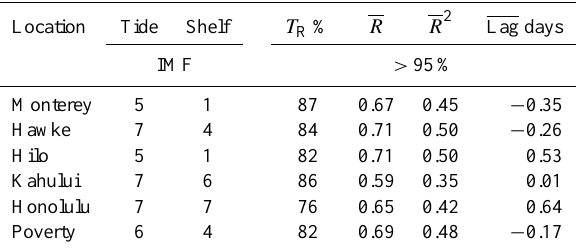
Table 6. Cross-correlation of fortnightly tide and shelf-resonance metamode IMFs. T R % is the percentage of time that the 95% con- fidence level is exceeded, R the mean value of 95% significant cor- relation over the record, and Lag the mean lag value of 95% signif- icant correlation over the